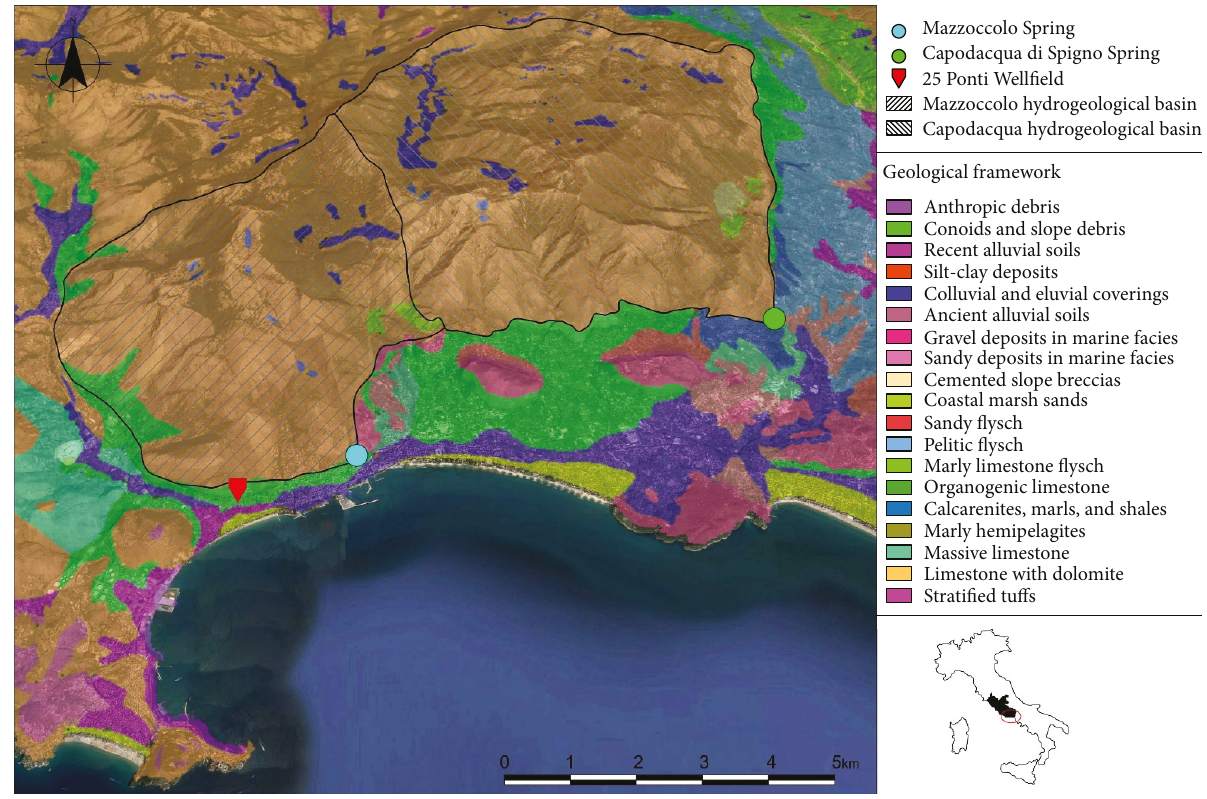
Figure 2: Geological framework of the study area.